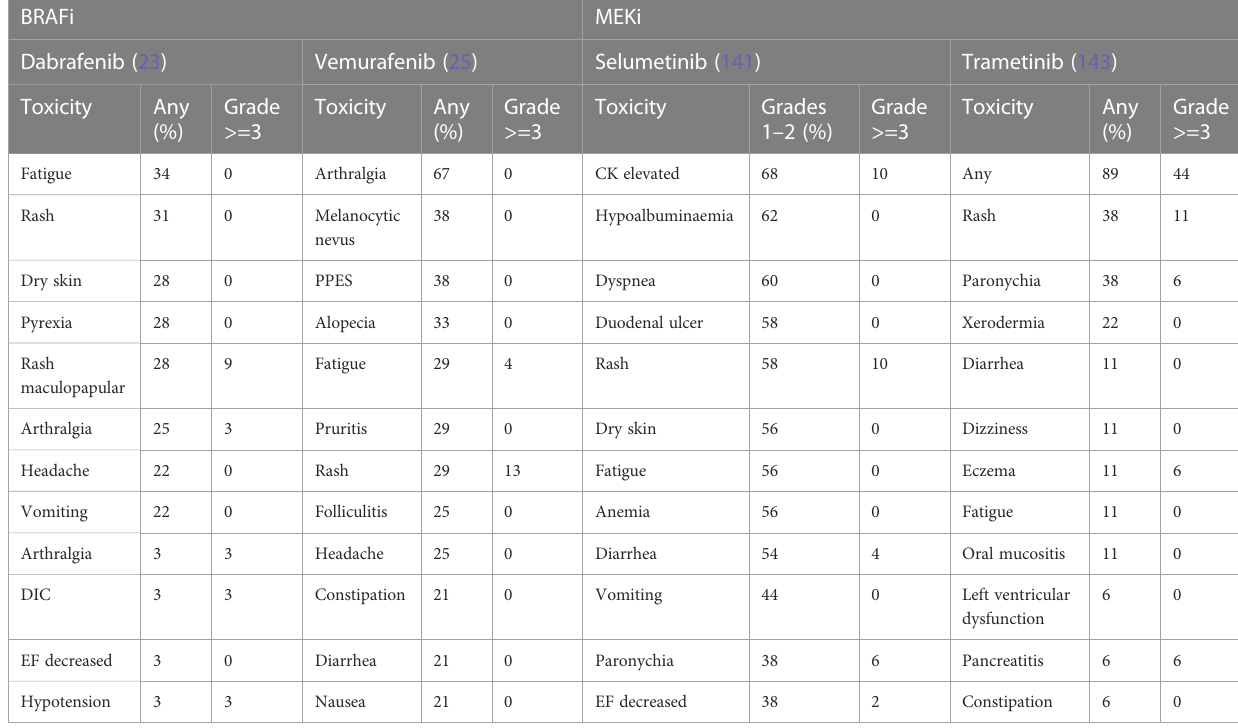
TABLE 2 Adverse events of BRAFi and MEKi monotherapy reported in glioma trials. BRAFi